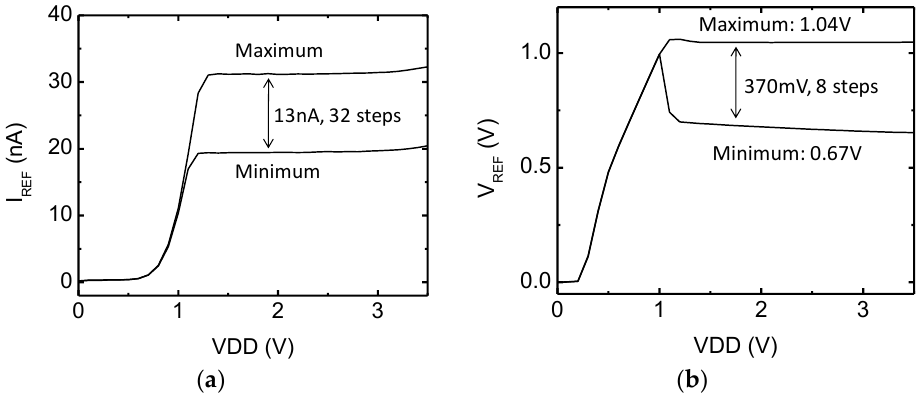
Figure 18. Measured outputs of the reference generator as a function of power supply voltage variations: ( a ) current reference and ( b ) voltage reference.